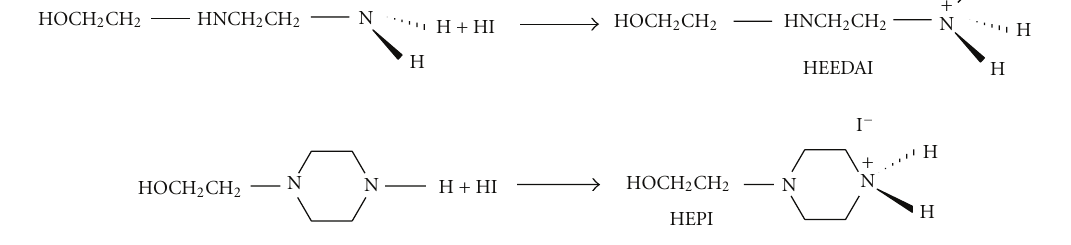
Scheme 1: The synthesis reaction of HEEDAI and HEPI.